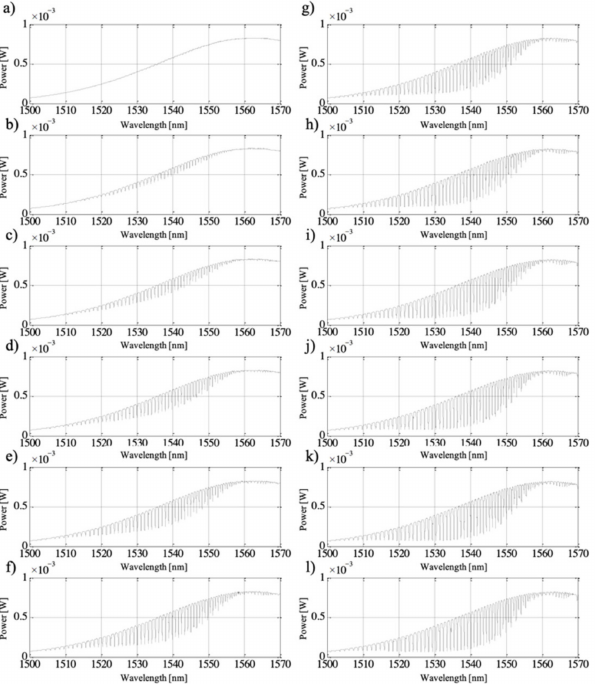
Figure 5. The process of TFBG structure formation on an optical fiber twisted by an angle equal to 180 ◦ . The figure shows the transmission characteristics measured at different times after switching on the laser: ( a ) 4 s, ( b ) 8 s, ( c ) 12 s, ( d ) 16 s, ( e ) 20 s, ( f ) 24 s, ( g ) 28 s, ( h ) 32 s, ( i ) 36 s, ( j ) 40 s, ( k ) 44 s, ( l ) 48